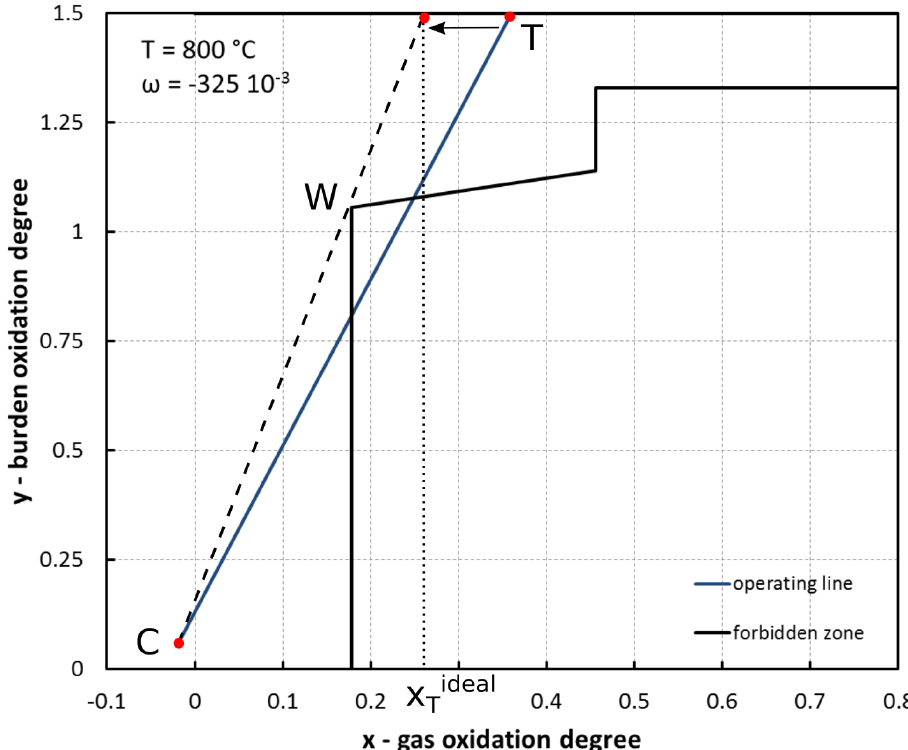
Figure 6. Operating diagram for an ideal